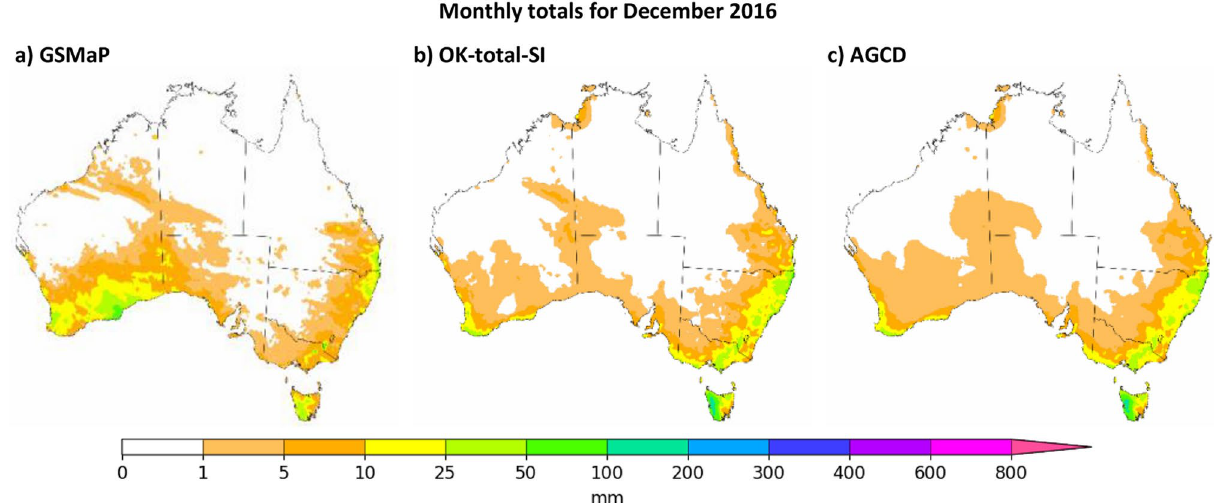
Figure 10. Visual comparison of September 2018 as represented by GSMaP-SI, OK-total-SI and AGCD. Figure created using Matplotlib 3.3.3 on